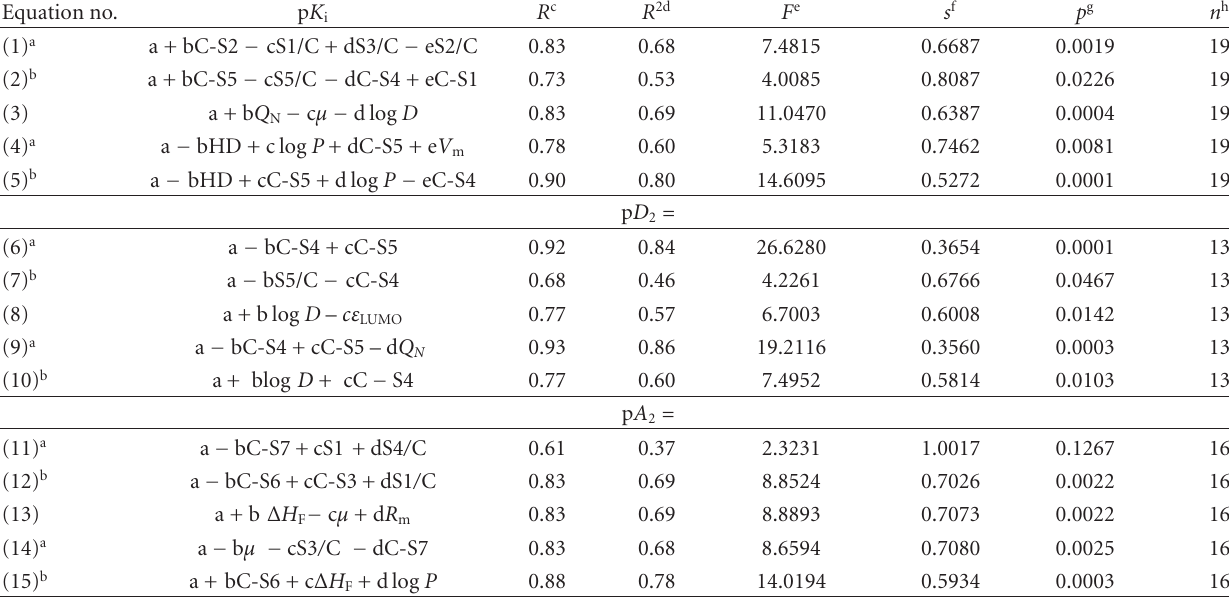
Table 4: Regression models for the correlation between values of biological activity ( pK i , pD 2 , pA 2 ) and chromatographic data and mol- ecular descriptors.